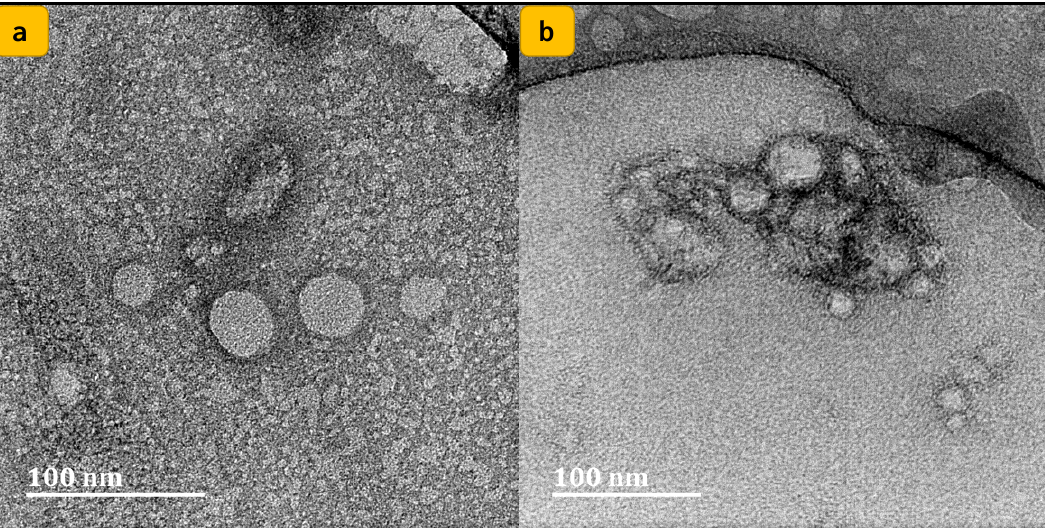
Figure 2. TEM images of cisplatin-loaded solid lipid nanoparticles (SLNs) with different magnification.